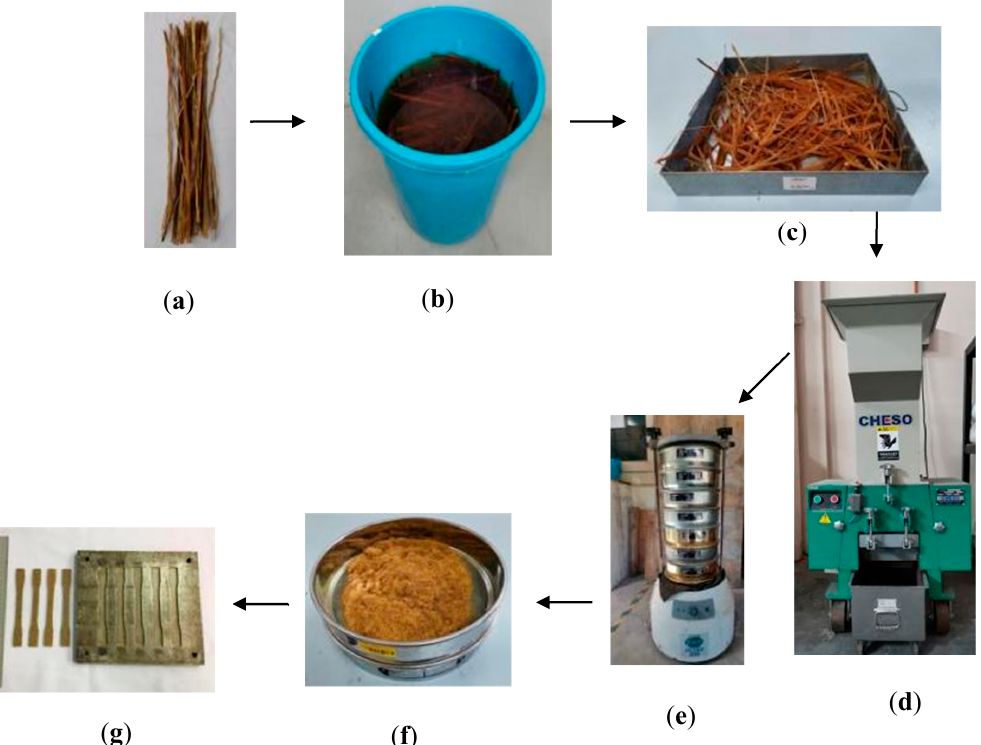
Figure 2. Typical chemical treatment process and dumbbell-shaped bamboo epoxy composite fabrication where ( a ) raw bamboo fibers, ( b ) soaking fibers into NaOH solution, ( c ) dried bamboo fibers, ( d ) grounding down fibers, ( e ) sieved the fibers, ( f ) obtaining the desired short bamboo fibers and ( g ) tensile-molded specimens.